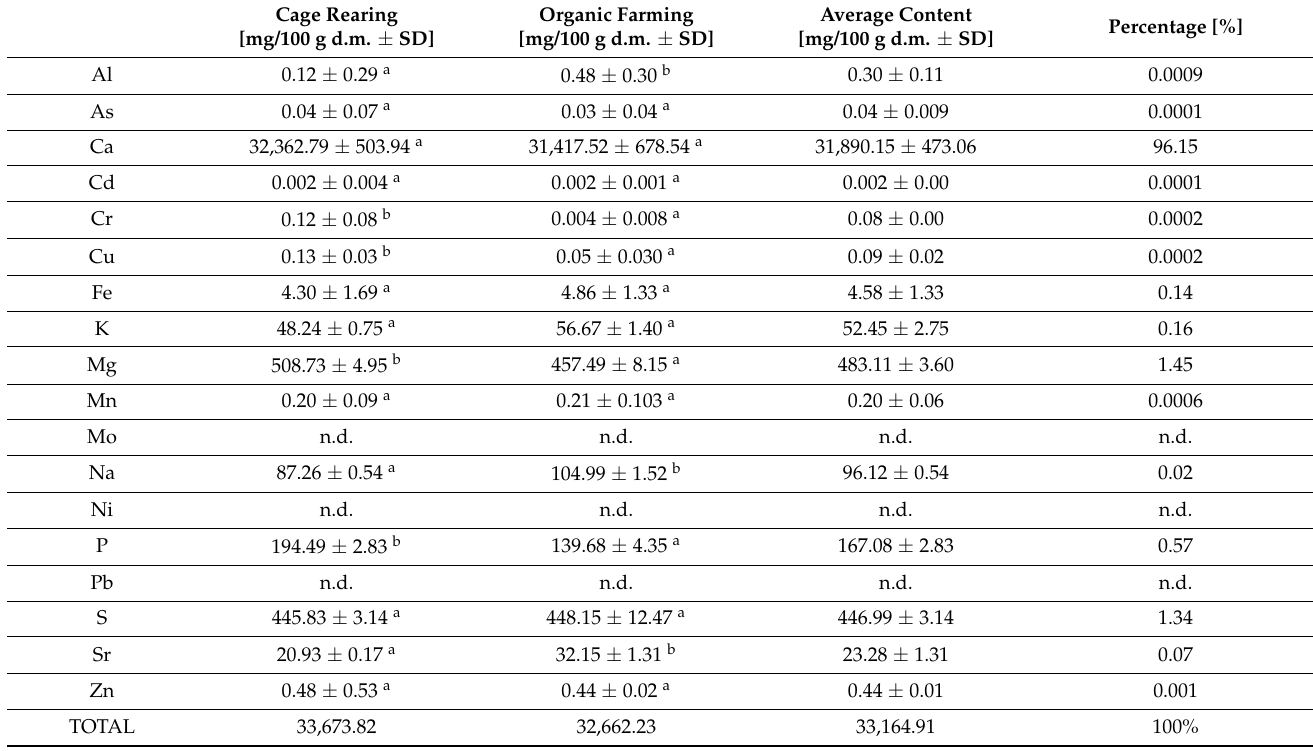
Table 3. The mineral content of the powdered shells of the eggs of various hen rearing systems. Cage Rearing [mg/100 g d.m. ±